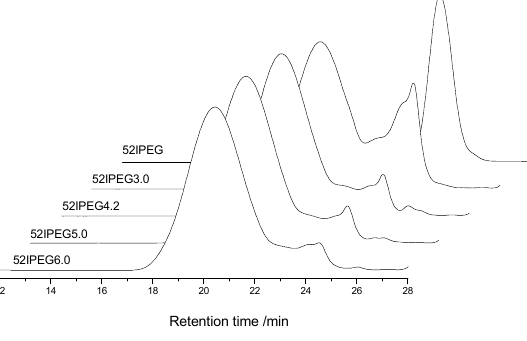
Figure 1. SEC (size exclusion chromatography) spectra of 52IPEG series polycarboxylate superplasticizer (PCE) at different feeding ratios of A to E .